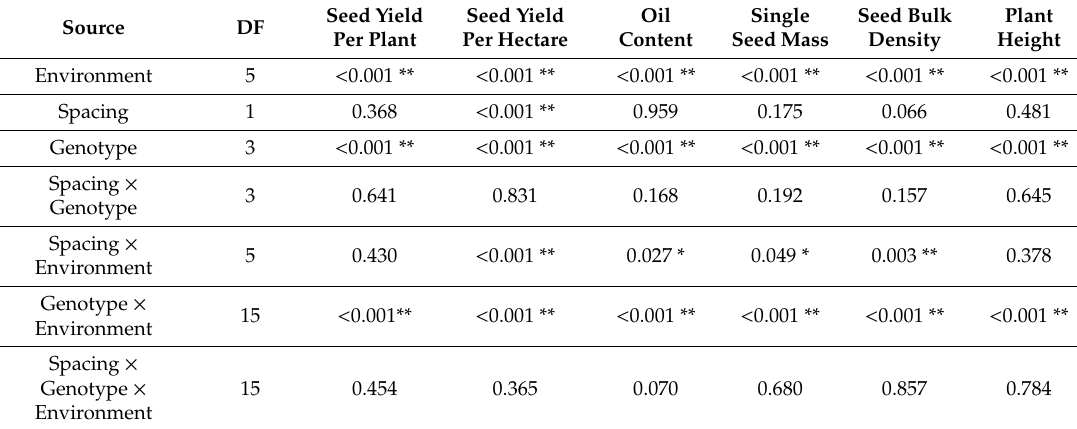
Table 2. P values of fixed effects from combined mixed model analyses across environments (DF = degrees of freedom).